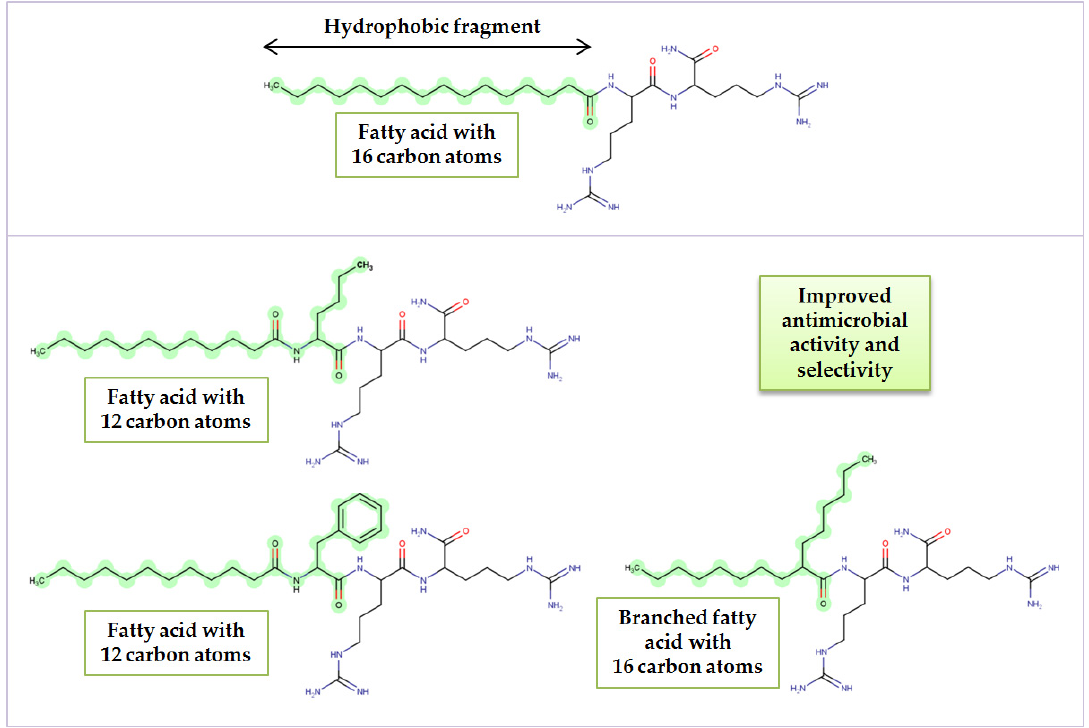
Figure 1. Effect of N -terminal amino acid and fatty acid type on antimicrobial activity and